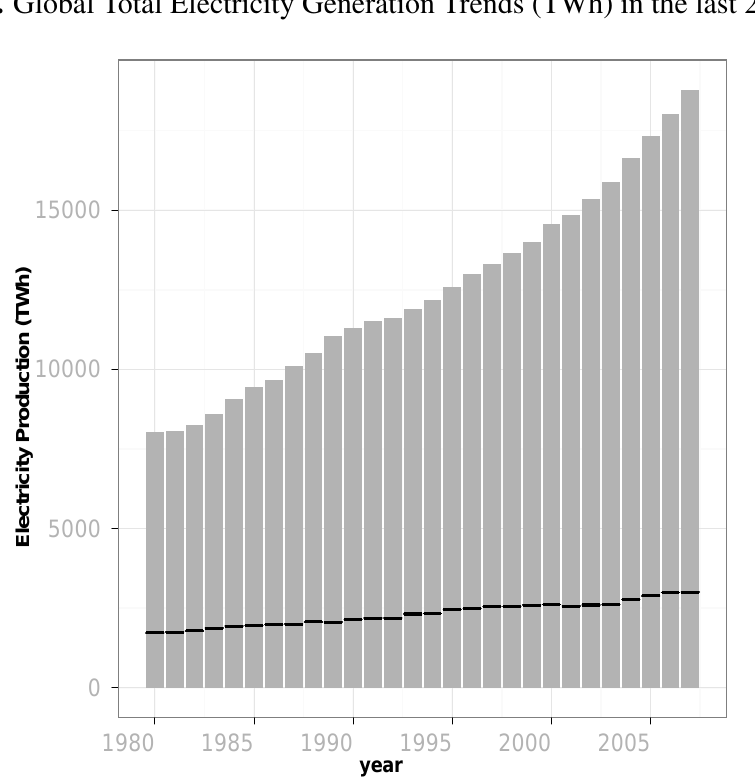
Figure 1. Global Total Electricity Generation Trends (TWh) in the last 20